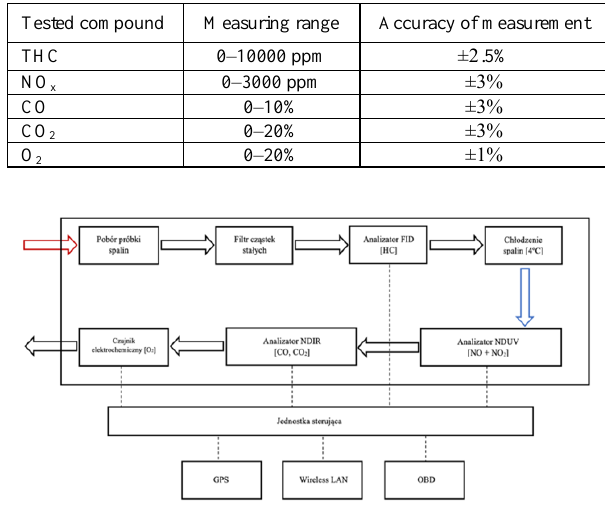
Table 2. Specification for measurement of exhaust gas compounds by Semtech DS [11]